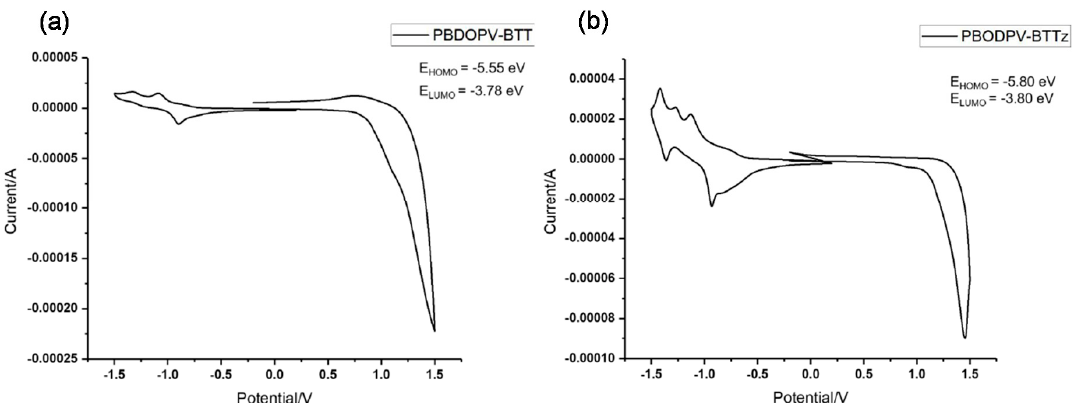
Figure 4. Cyclic voltammograms of ( a ) PBDOPV-BTT and ( b ) PBDOPV-BTTz films drop-cast on a glassy carbon electrode, measured in CH 3 CN with 0.1 M ( n C 4 H 9 ) 4 NClO 4 at the scan rate of 0.1 V s − 1 .